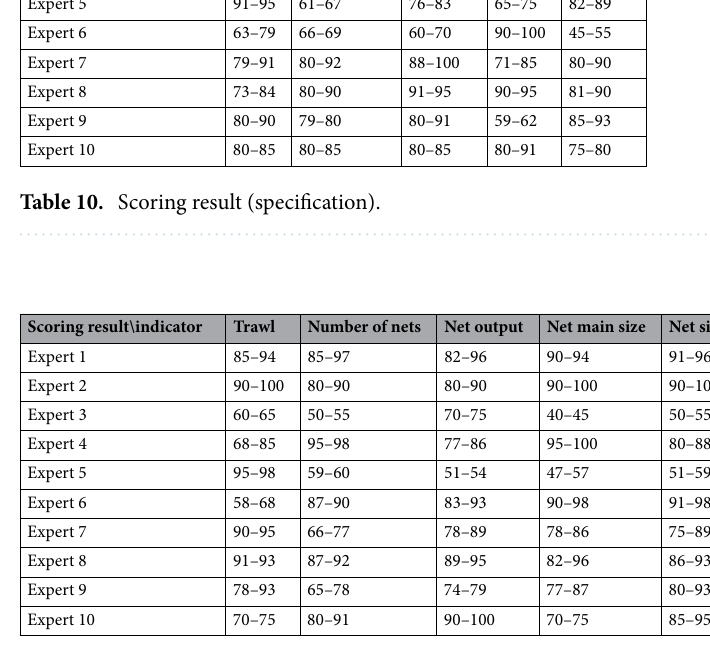
Table 11. Scoring result(Net).